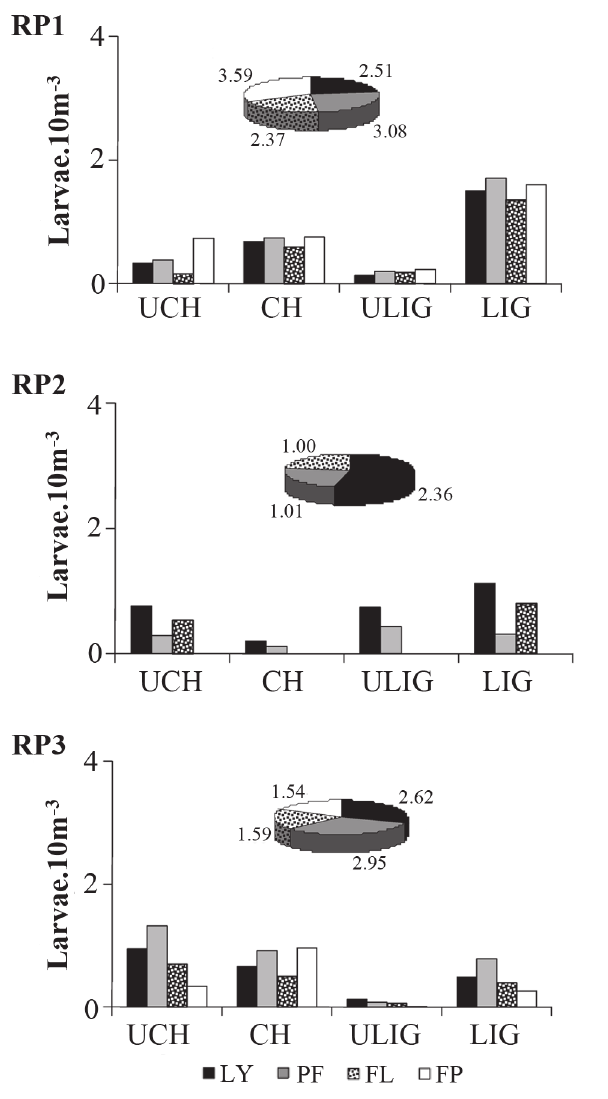
Fig. 2. Abundance of fish larvae in different stages of development recorded in the sampling sites of the upper Uruguay River from October 2001 to March 2004. Larval development stages: LY = Larval Yolk; PF = Pre-flexion; FL = Flexion and FP = Post-flexion. Sampling sites: LIG: Ligeiro, ULIG: Uruguay-Ligeiro, CH: Chapecó and UCH: Uruguay- Chapecó. Reproductive Periods: RP1: First Reproductive Period, RP2: Second Reproductive Period and RP3: Third Reproductive